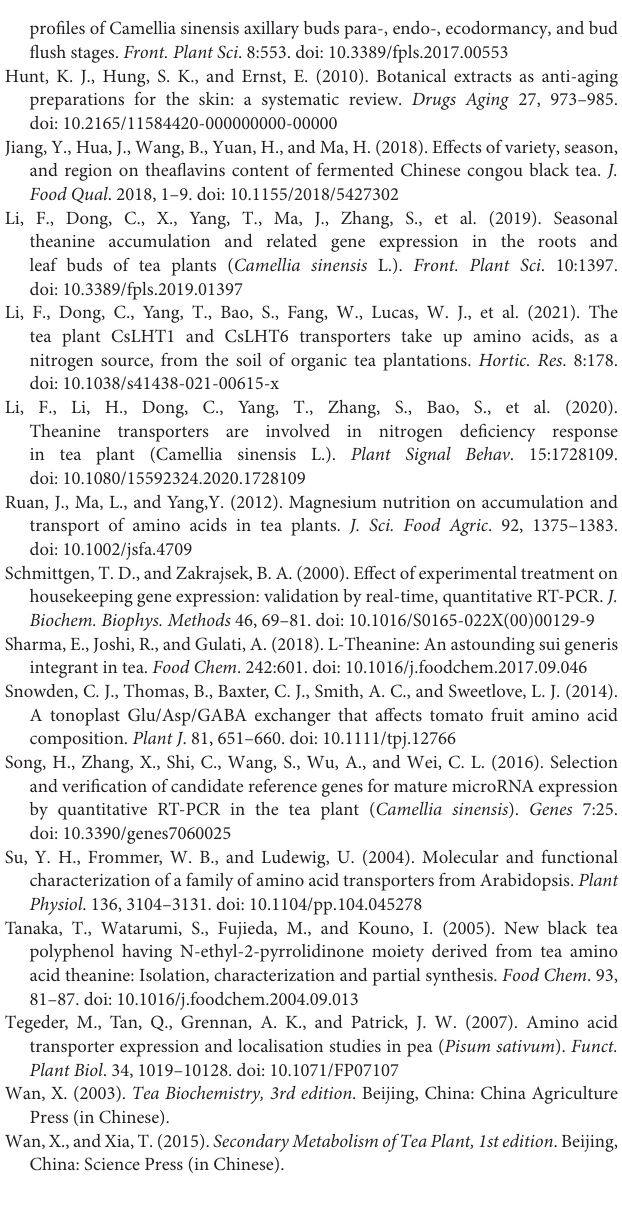
Supplementary Figure 1 | Growth of yeast strains on medium with amino acid as sole nitrogen source, with 0 nitrogen (-N) and 2mM (NH 4 ) 2 SO 4 as negative and positive controls. Supplementary Table 1 | Primers used in the